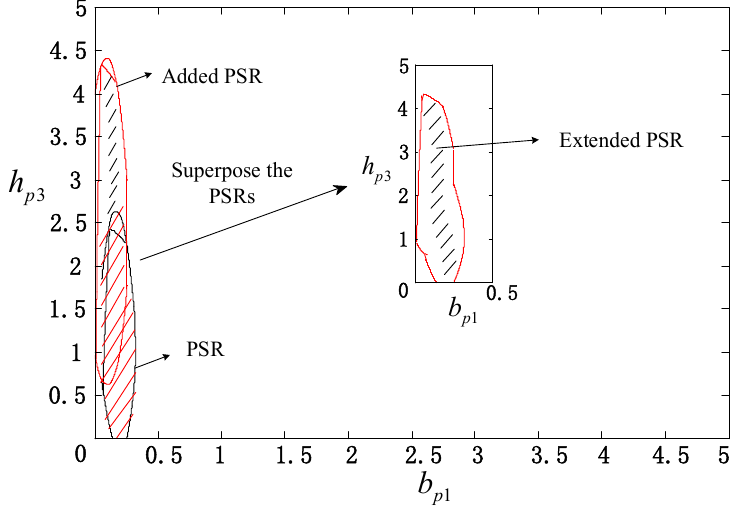
Figure 6. The extended PSR of h p3 -b p1 .